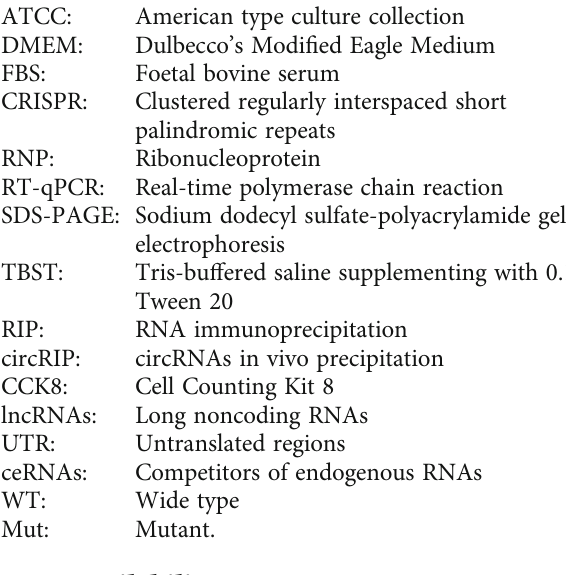
Supplementary 1 . Table S1: primers and sequences. Supplementary 2 . Figure S1: the scheme illustrating the production of